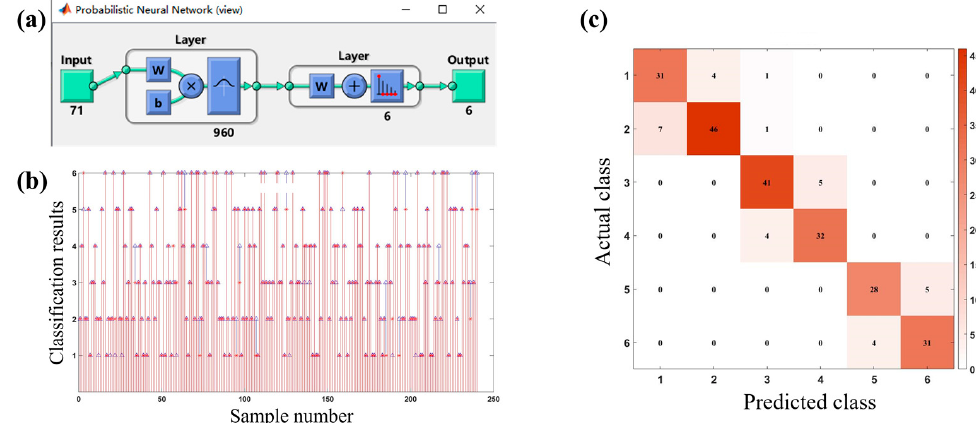
Figure 14. Building and testing of object recognition model. ( a ) Overall structure of PNN algorithm; ( b ) test results of sample data; ( c ) confusion matrix. Table 1. Recognition accuracy of object recognition model. Object